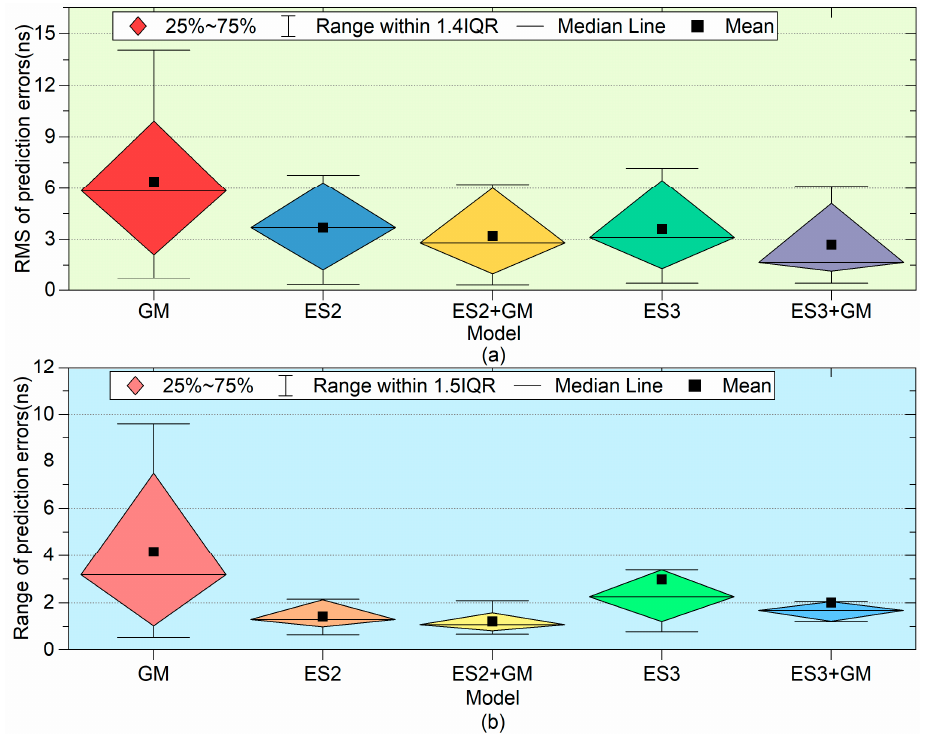
Figure 8. Boxplot change diagram of 6 h prediction accuracy ( a ) and stability ( b ) using different models.